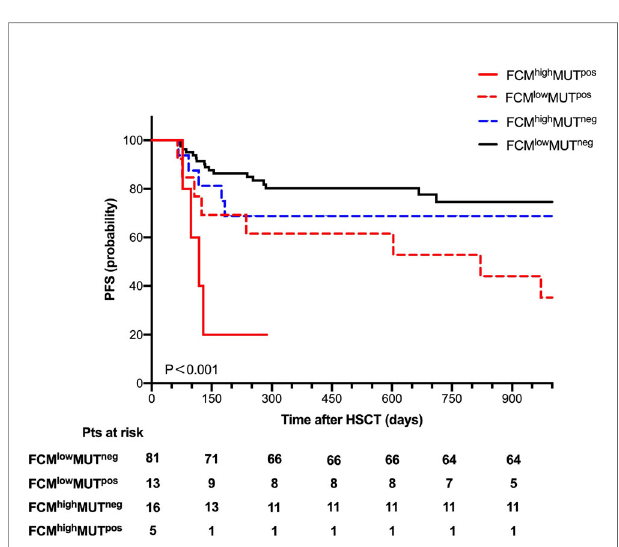
FIGURE 2 | Overall survival (A) and progression-free survival (B) for 115 patients according to FCM MRD.